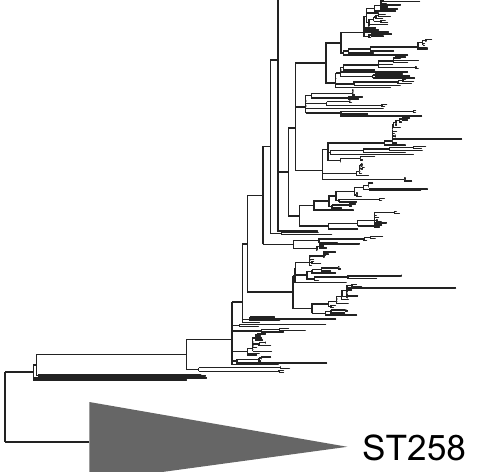
signi fi cantly different abundance between OL101:K47 and O2v1:KL64 are shown. Thereplicontypescorrespondingtotheprevalentvirulence[IncHI1B(pNDM-MAR) andIncFIB(Kpn3)]andMDRplasmid[IncFII(pCRY)]carryingtheseARGs(exceptfor oqxAB ) are shown here. The RecC allele (RecC His935Arg ) was detected exclusively in O2v1:KL64, as shown on the branch, and the reference (KP37485) used in the recombination assayisindicated on the tree. Source data are provided asa Source Data fi